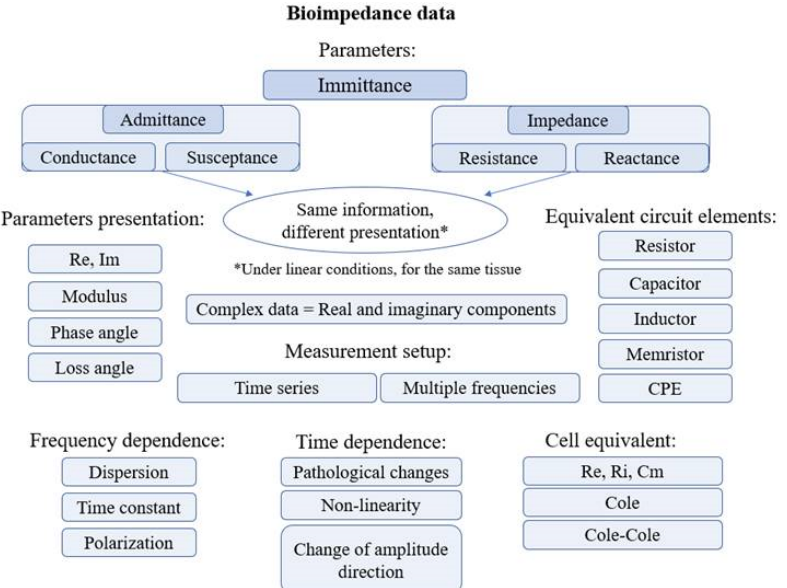
Figure 1. An overview over typical ways to present bioimpedance data, showing the level of complexity within the realm of presenting and analyzing bioimpedance